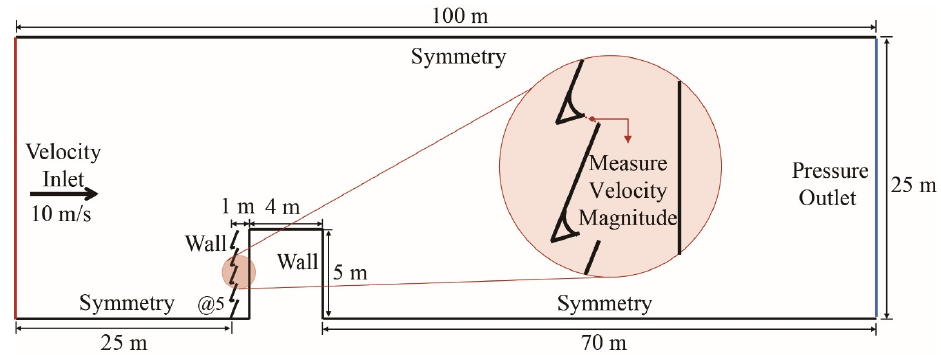
Figure 7. Computational fluid dynamics (CFD) simulation domain for the guide vane analyses.